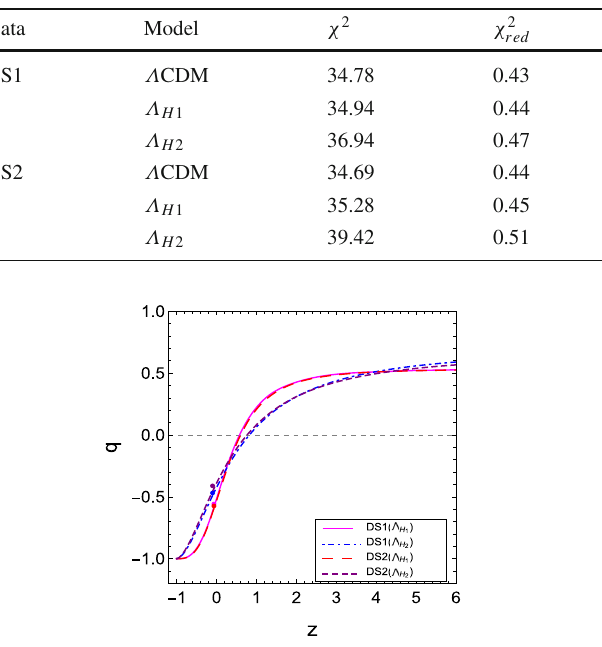
Fig. 6 The redshift evolution of effective EoS parameter for Λ H 1 and Λ H 2 models using DS1 and DS2 data sets. A dot denotes the present value of the EoS parameter